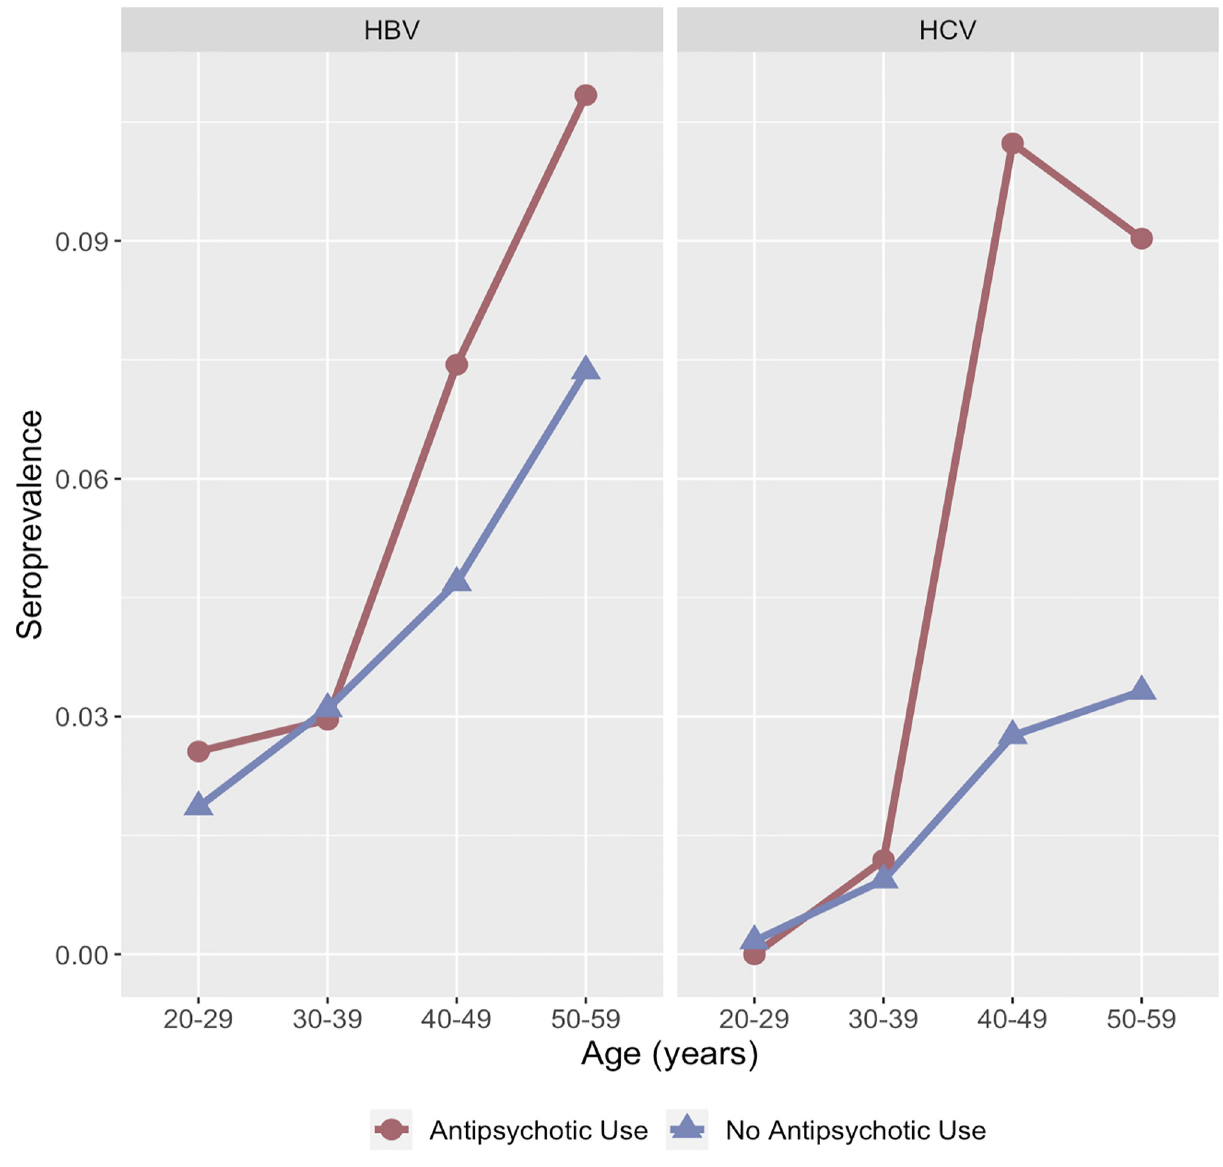
Fig 2. Population weighted seroprevalence of hepatitis B virus (HBV) and hepatitis C virus (HCV) by age group among respondents to the 2005– 2014 National Health and Nutrition Examination Survey ( n = 16,960).